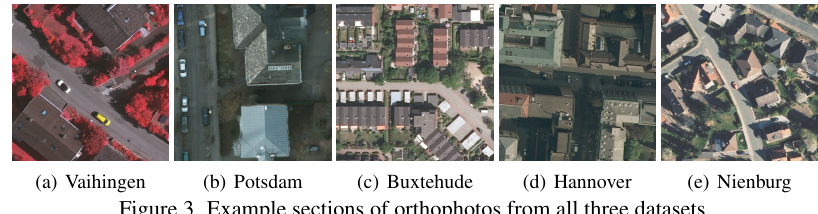
Figure 3. Example sections of orthophotos from all three